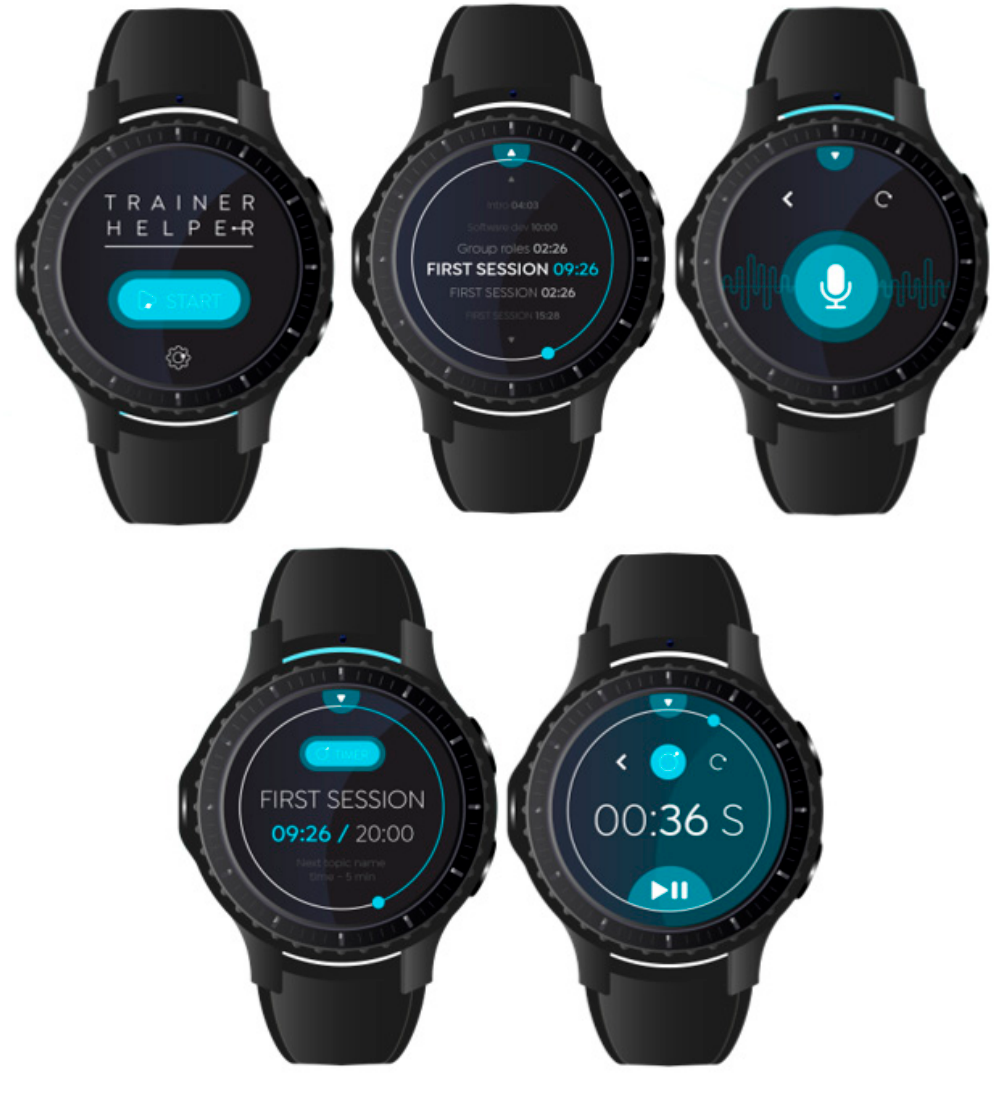
Figure 6. Trainer Companion